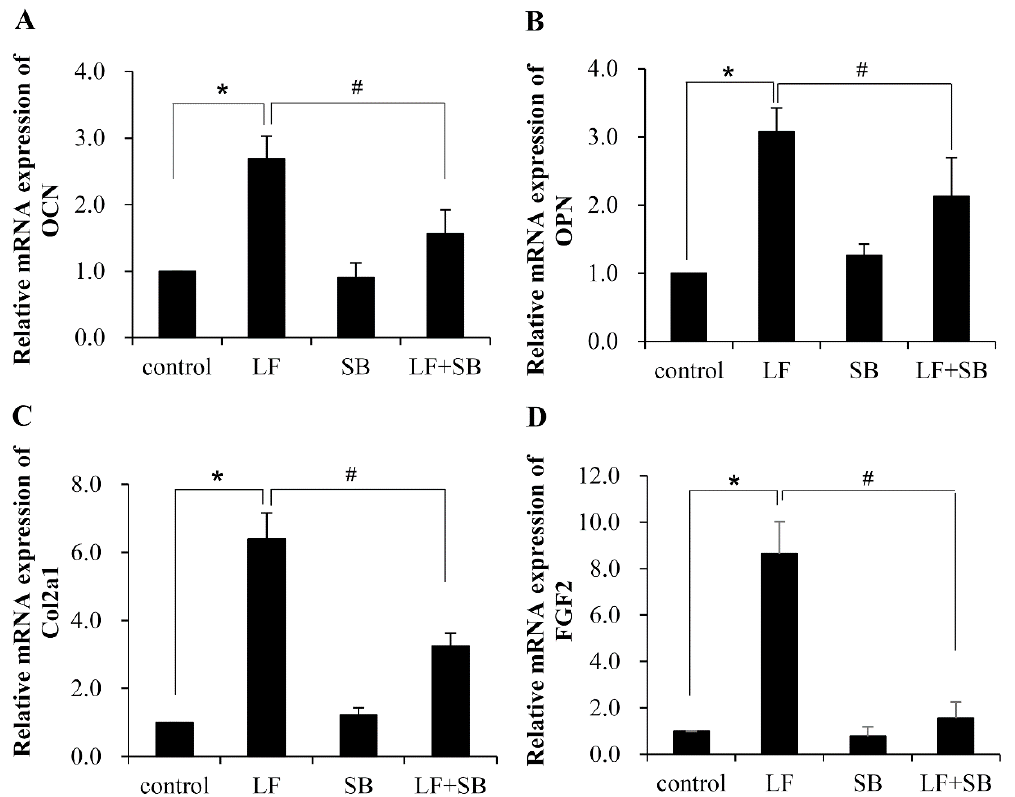
Figure 2. Transforming growth factor β (TGF- β ) pathway is involved in LF-induced upregulation of osteogenic factors in C3H10T1 / 2 MSCs. C3H10T1 / 2 cells were pretreated with SB for one hour and followed by treatment with LF for four hours. Expression of OCN ( A ), OPN ( B ), Col2a1 ( C ), and FGF2 ( D ) were measured by Quantitative Real-Time PCR (q-RT-PCR). Values are mean ± SDs, n = 3 (means of five replicates). (* p < 0.05 versus control group; # p < 0.05 versus LF + SB treated group).